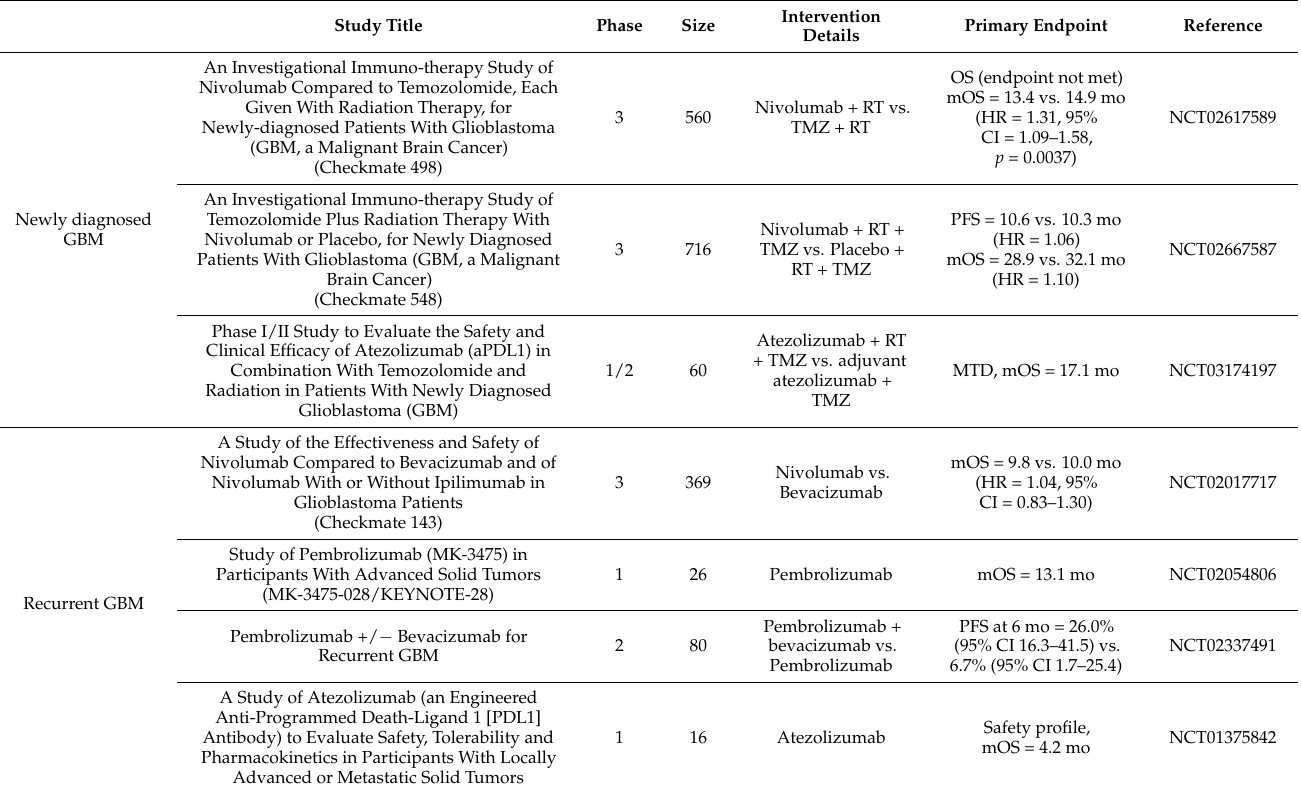
Table 3. Immune checkpoint inhibitor clinical trials for